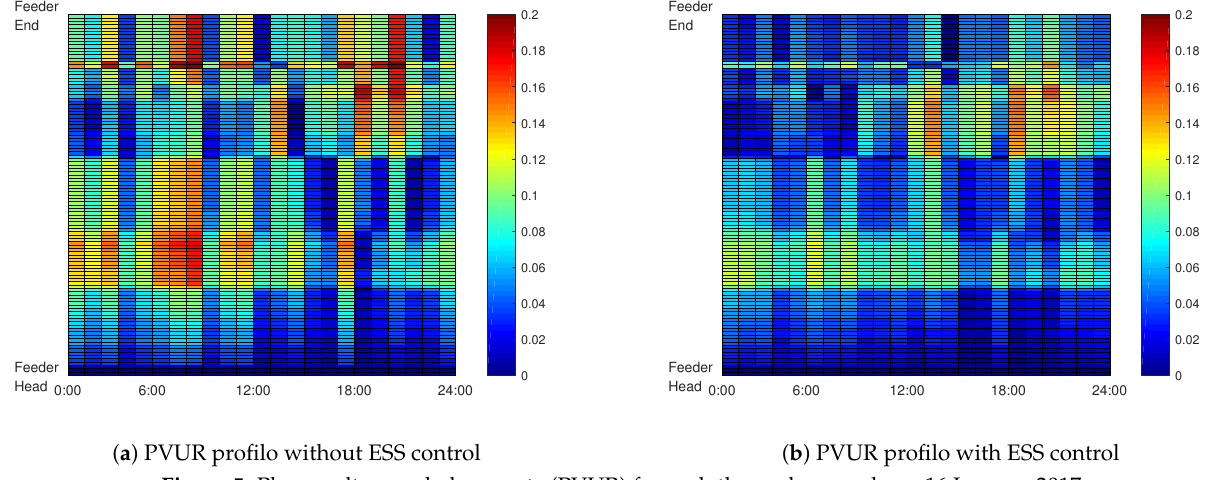
Figure 5. Phase voltage unbalance rate (PVUR) for each three-phase node on 16 January